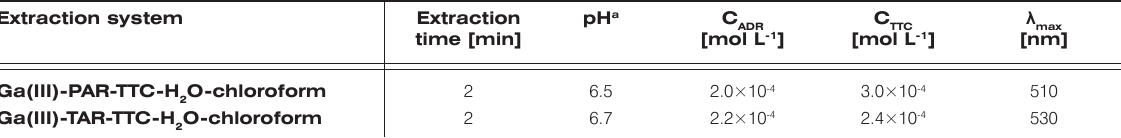
Table 2. Optimum operating conditions. Extraction system